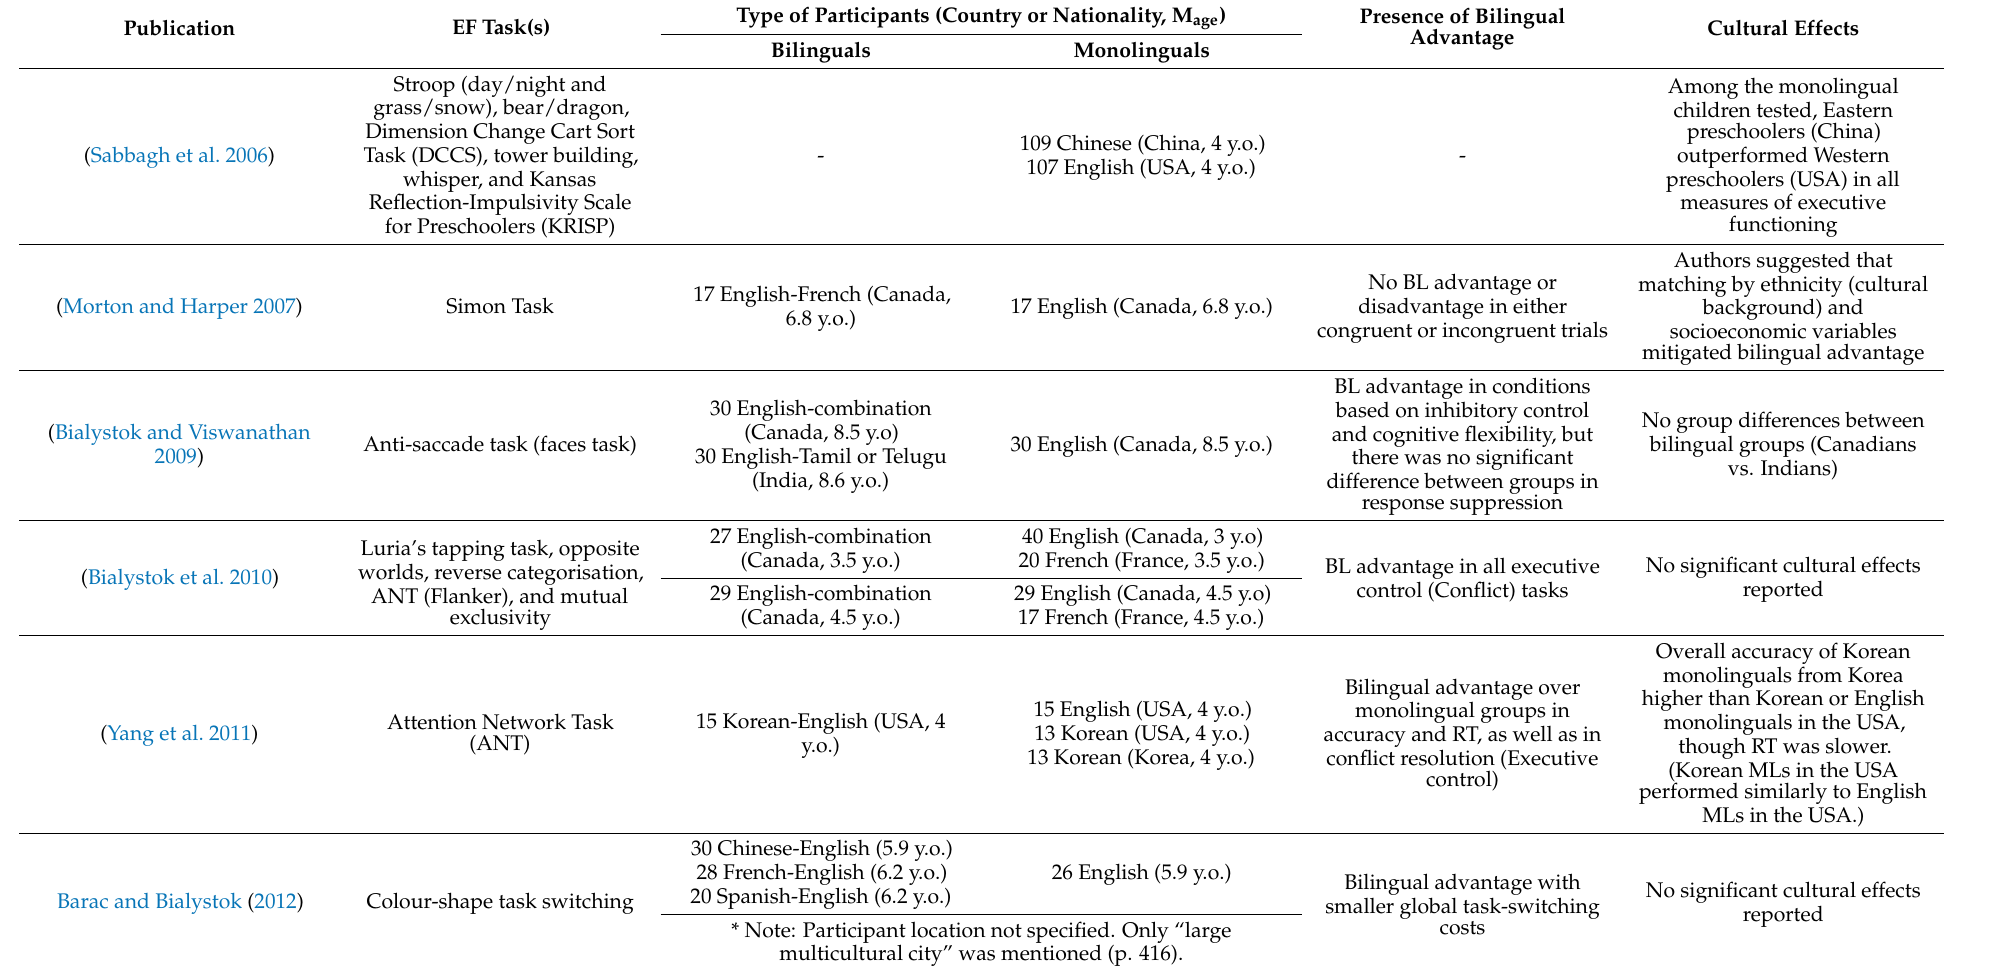
Table A1. List of key publications explicitly discussing culture in studies on bilingual EF. Asterisk (*) indicates a note about the participant